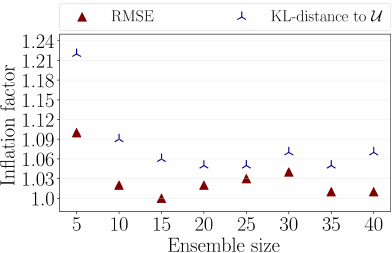
Figure 16. Data assimilation results with DEnKF applied to Lorenz-96 system. The minimum average RMSE over the inter- val [ 10 , 30 ] is indicated by red triangles. The minimum average KL distance between the analysis rank histogram and a uniformly dis- tributed rank histogram [ 10 , 30 ] is indicated by blue tripods. We show the results for every choice of the ensemble size. The local- ization radius is fixed to